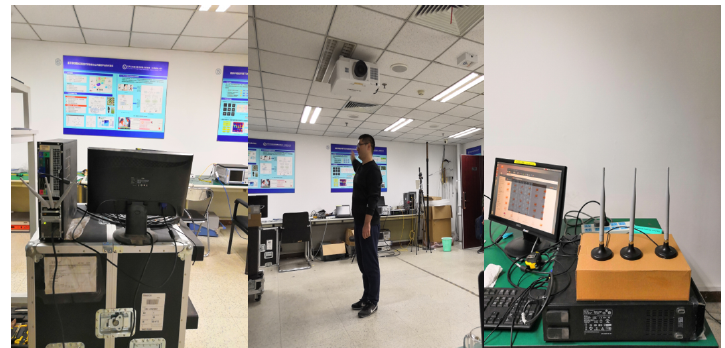
Figure 9. Data collection experimental